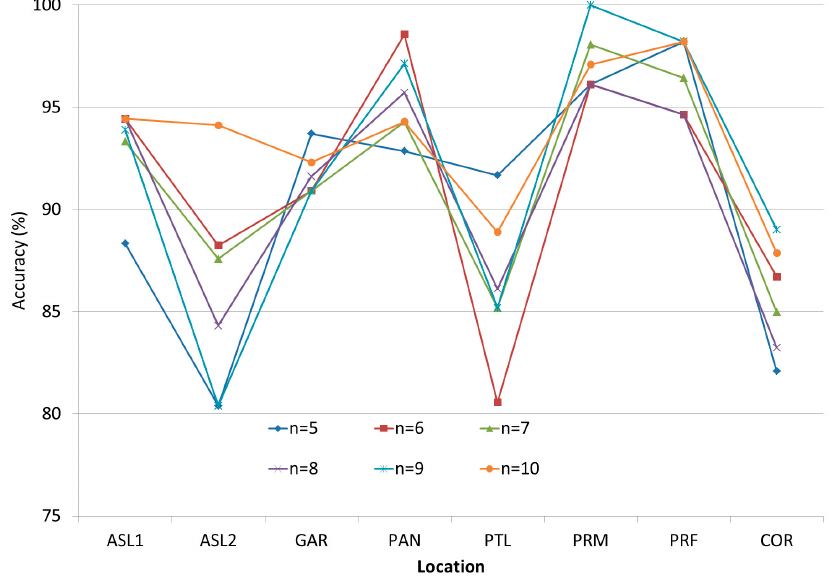
Figure 6. The accuracy of IPS when using KNN in each room.